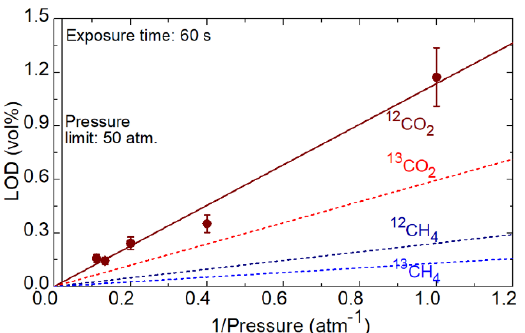
Figure 5. Limit of detection (LOD) of chemically pure isotopically enriched carbon dioxide and methane gases vs . inverse of the gas pressure: symbols : experimental data for 12 CO 2 using the 1388 cm −1 Raman line, solid line —their linear fit, dashed lines —interpolation for other gases according to the measurement at 1 atm. Exposure time: 60 s.